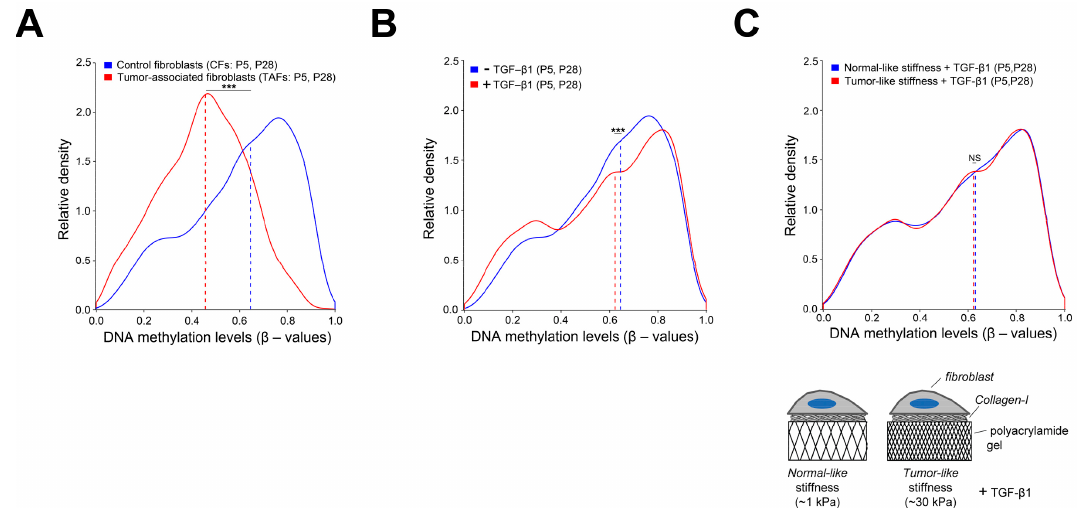
Figure 2. Potential causes of the global DNA hypomethylation of lung TAFs. ( A ) Histogram of the relative density of the average DNA methylation levels ( β -values) of 2 TAFs (red line) and paired CFs (blue line). Dashed lines indicate the median β -value of each histogram. *** p < 0.001. ( B , C ) Histograms of the relative density of the average β -values of 2 CFs cultured either with TGF- β 1 in stiff substrata ( B ) or in hydrogels exhibiting soft or stiff (tumor-like) rigidities in the absence of TGF- β 1 ( C ). Note that the shift of the median β -value towards lower values elicited by TGF- β 1 is larger than that elicited by stiff versus soft hydrogels, yet it did not attain the larger shift observed in TAFs. All plots reprinted from [32] with permission. *** p <